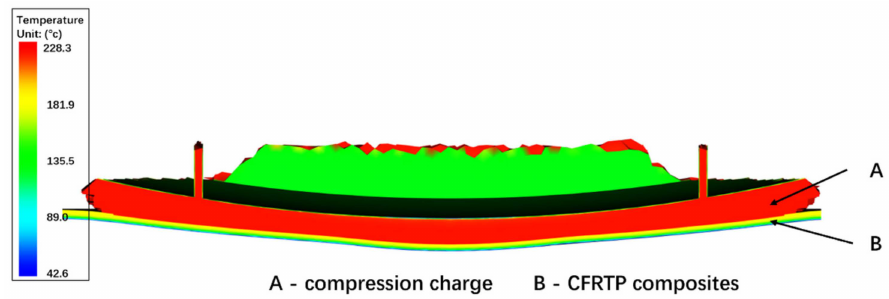
Figure 15. Temperature of compression charge and CFRTP composites at 0.3